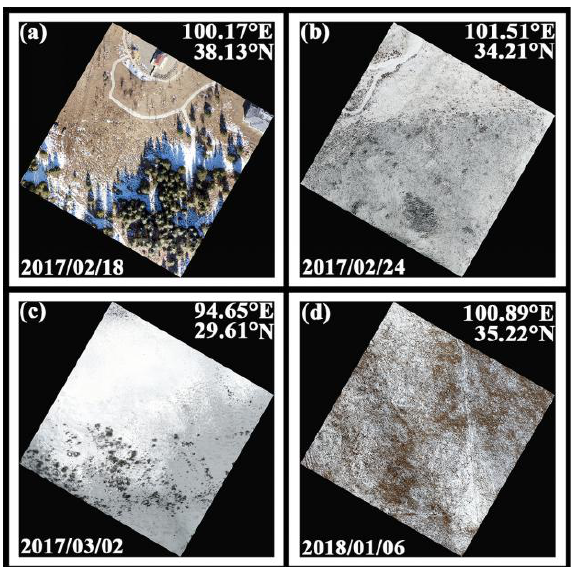
Figure 2. UAV-captured true color composed images under the ( a ) forestland, ( b ) grassland, ( c ) shrubland and ( d ) bare land in Tibetan Plateau. Each image covers a range of 500 m × 500 m.